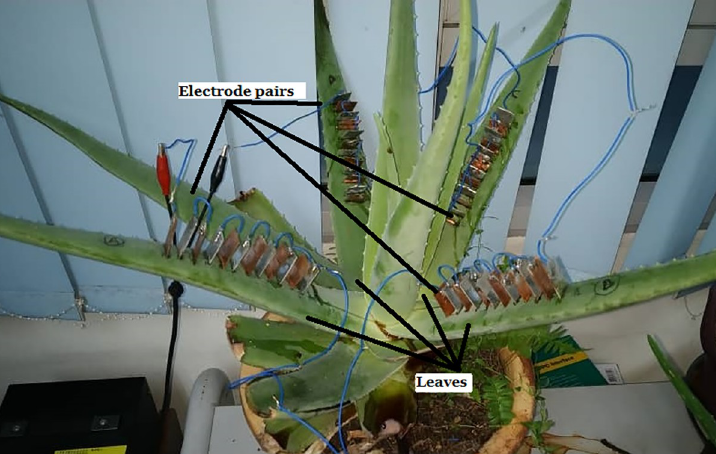
Fig 7. Experiment setup for series connection among leaves which passing through the stem of the Aloe